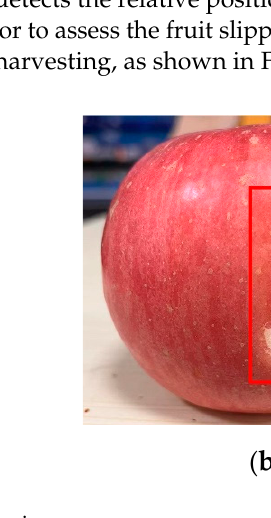
Figure 10. Model of the soft gripper control method: ( a ) the relationship among f c , F, and M d ; ( b ) Relative position detection between fthe ruit and the gripper.